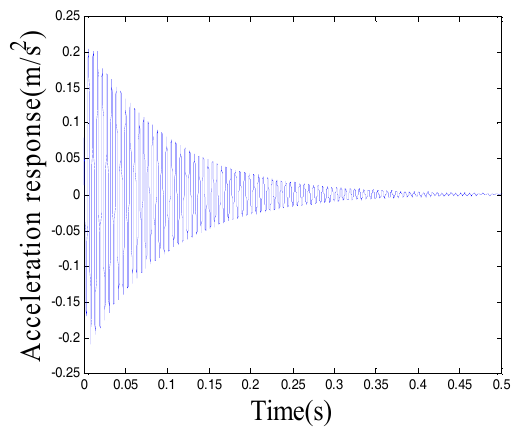
Figure 6. Frequency response.